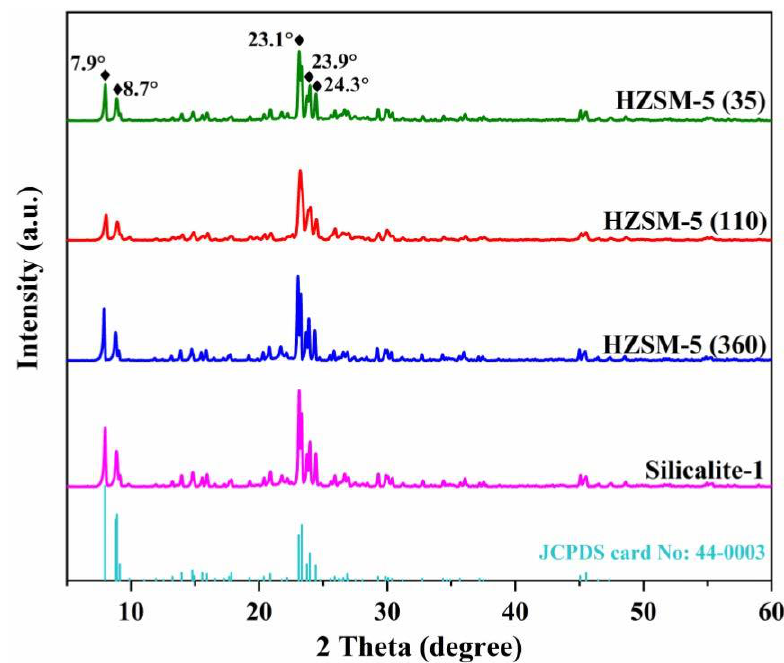
Figure 2. XRD patterns of all samples.